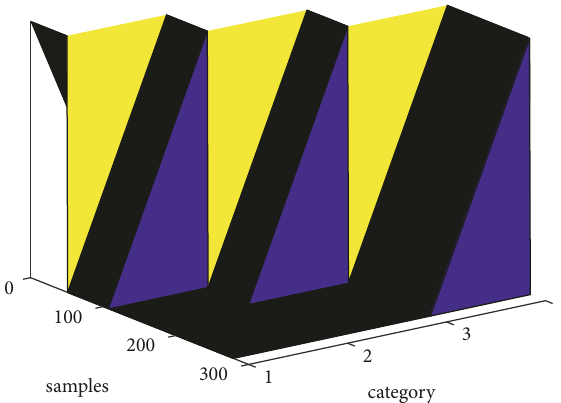
Figure 8: Simulation error curves of the GA-BP neural network. Figure 6: Simulation error curves of BP neural network. Evolutionary process